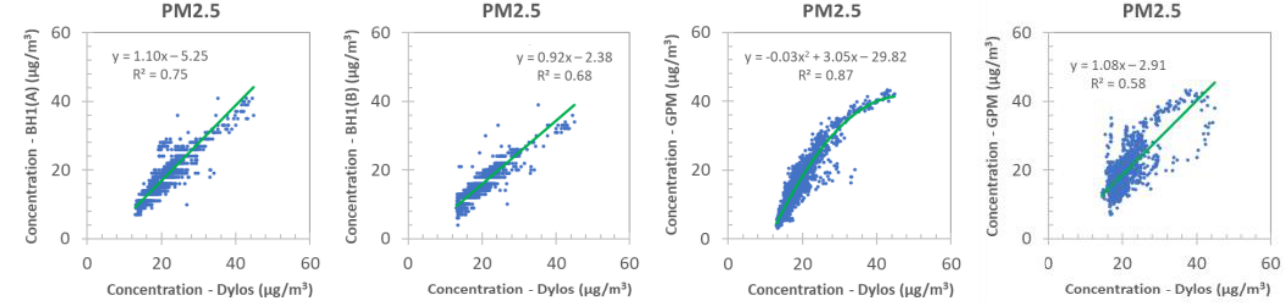
Figure 11. Linear and nonlinear calibration plots of PM 2.5 readings for BH1 (left) and GPM (right) sensors against the Dylos reference monitor studied at the suburban site between 15 and 18 April, 2022 (sampling rate: 1–5 min, n = 3640).